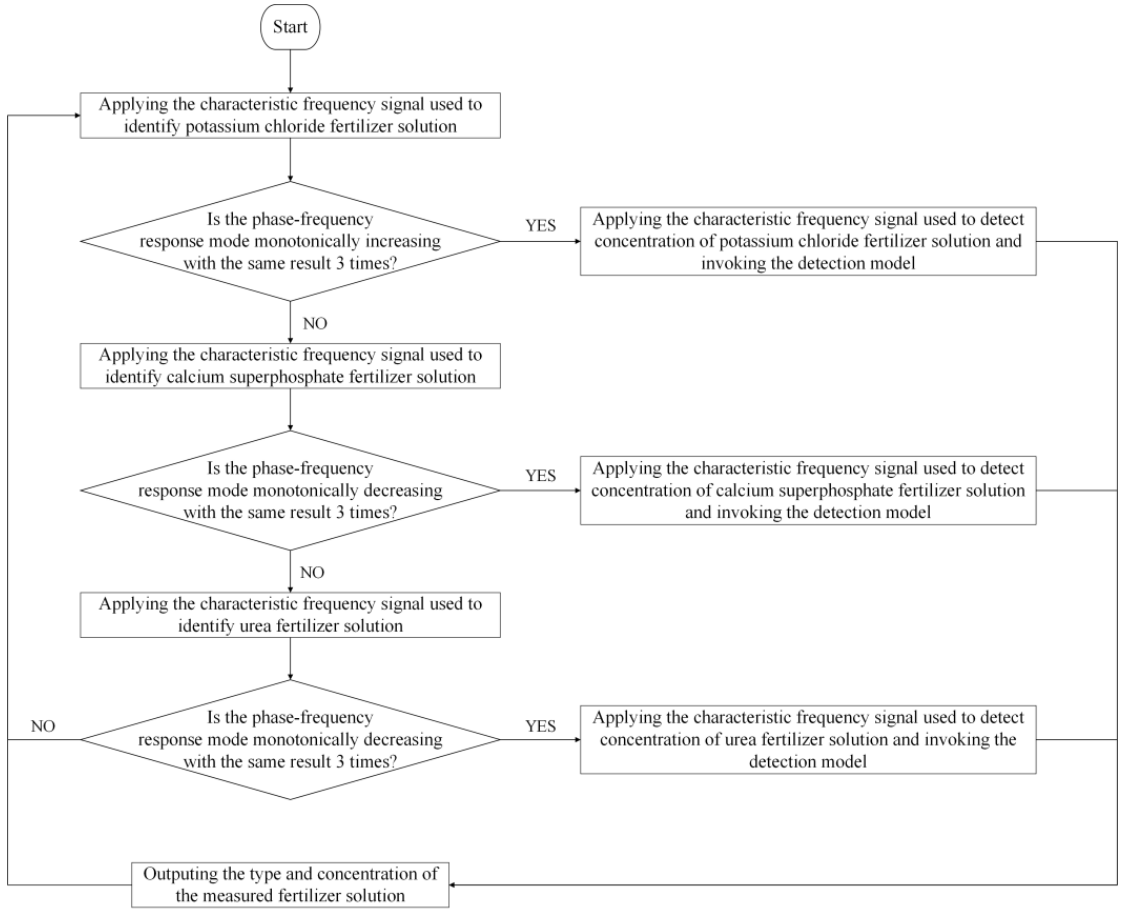
Figure 14. Identification of fertilizer solution type and its concentration detection strategy.